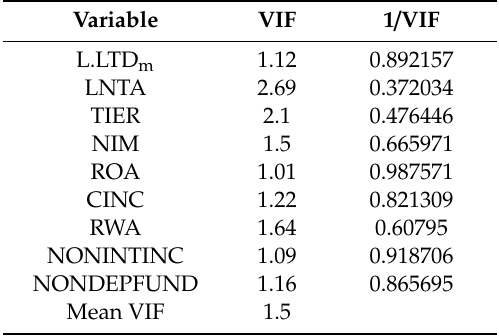
Table A2. The Variance Inflation Factor (VIF) and Tolerance Test Statistics.